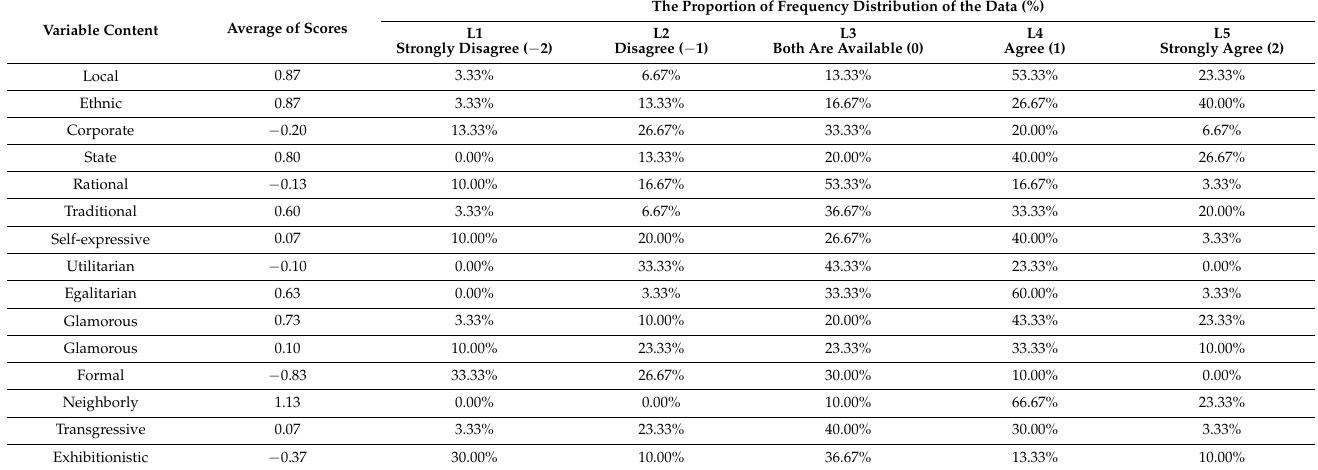
Table 4. Semantic rating scale.